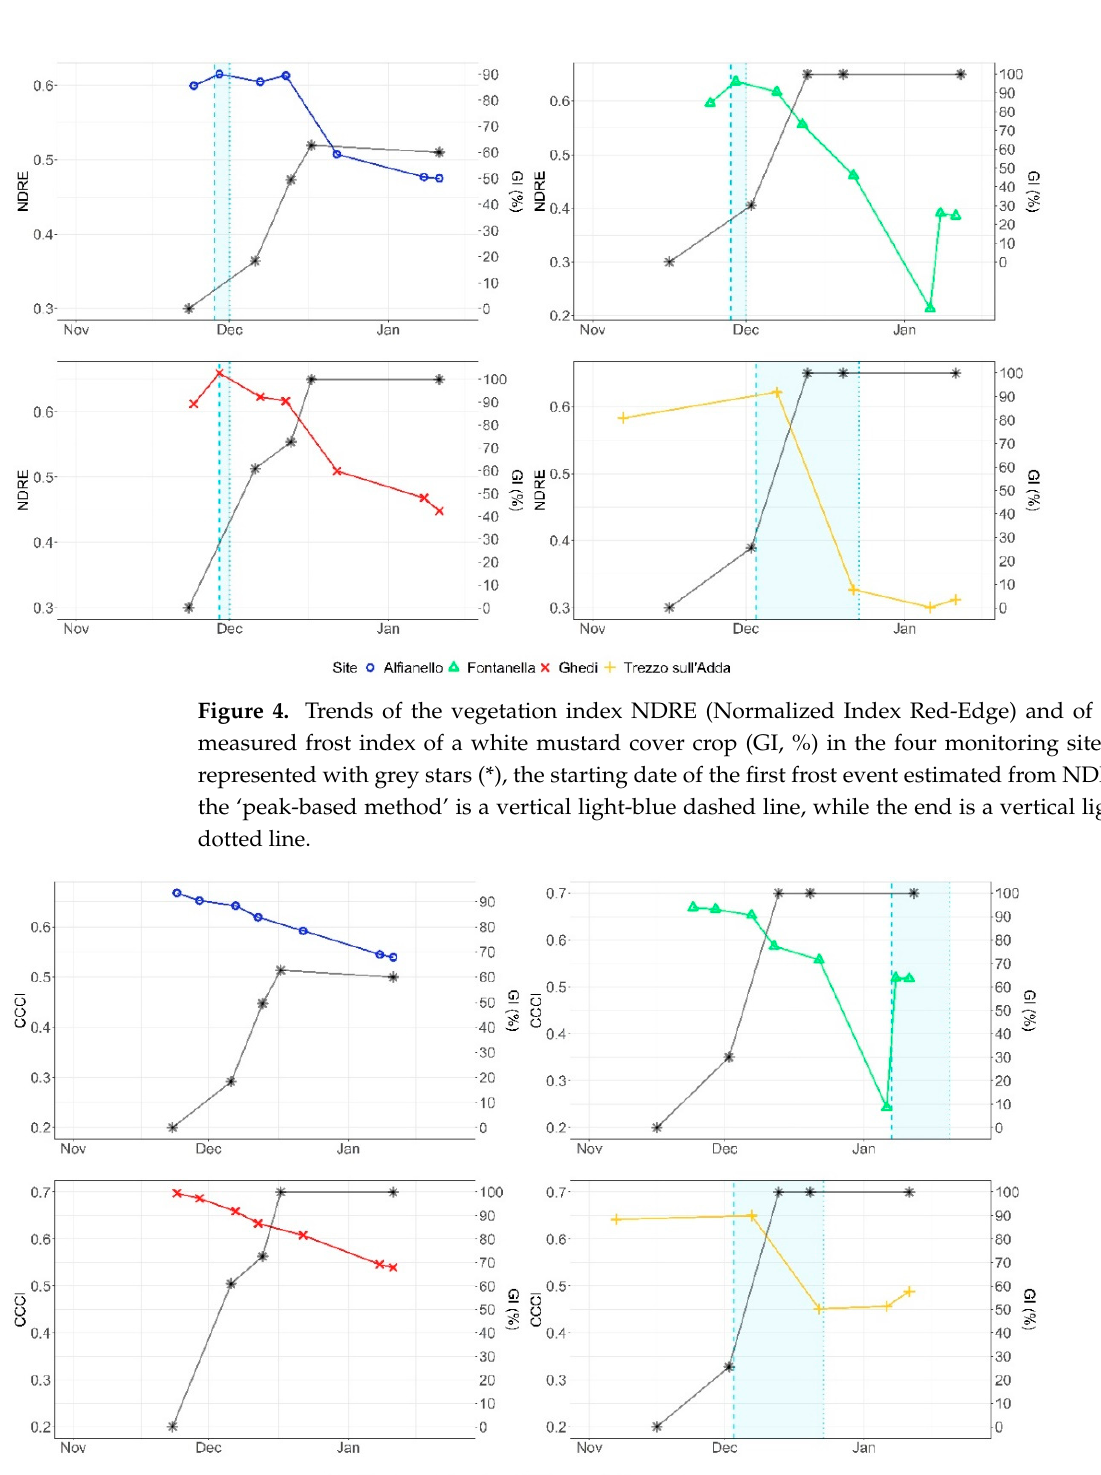
Figure 5. Trends of the vegetation index CCCI (Canopy Chlorophyll Content Index) and of ground- measured frost index of a white mustard cover crop (GI, %) in the four monitoring sites. GI is represented with grey stars (*), the starting date of the first frost event estimated from MMSR with the ‘peak-based method’ is a vertical light-blue dashed line, while the end is a vertical light-blue dotted line.